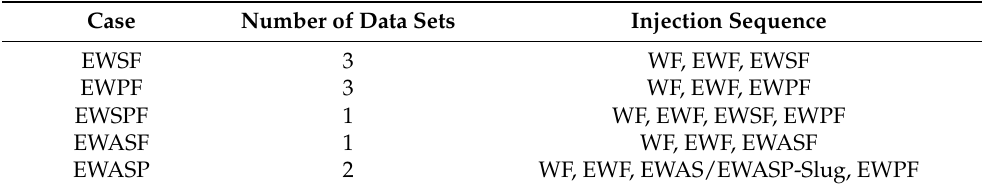
Table 1. Number of tests conducted and their respective injection